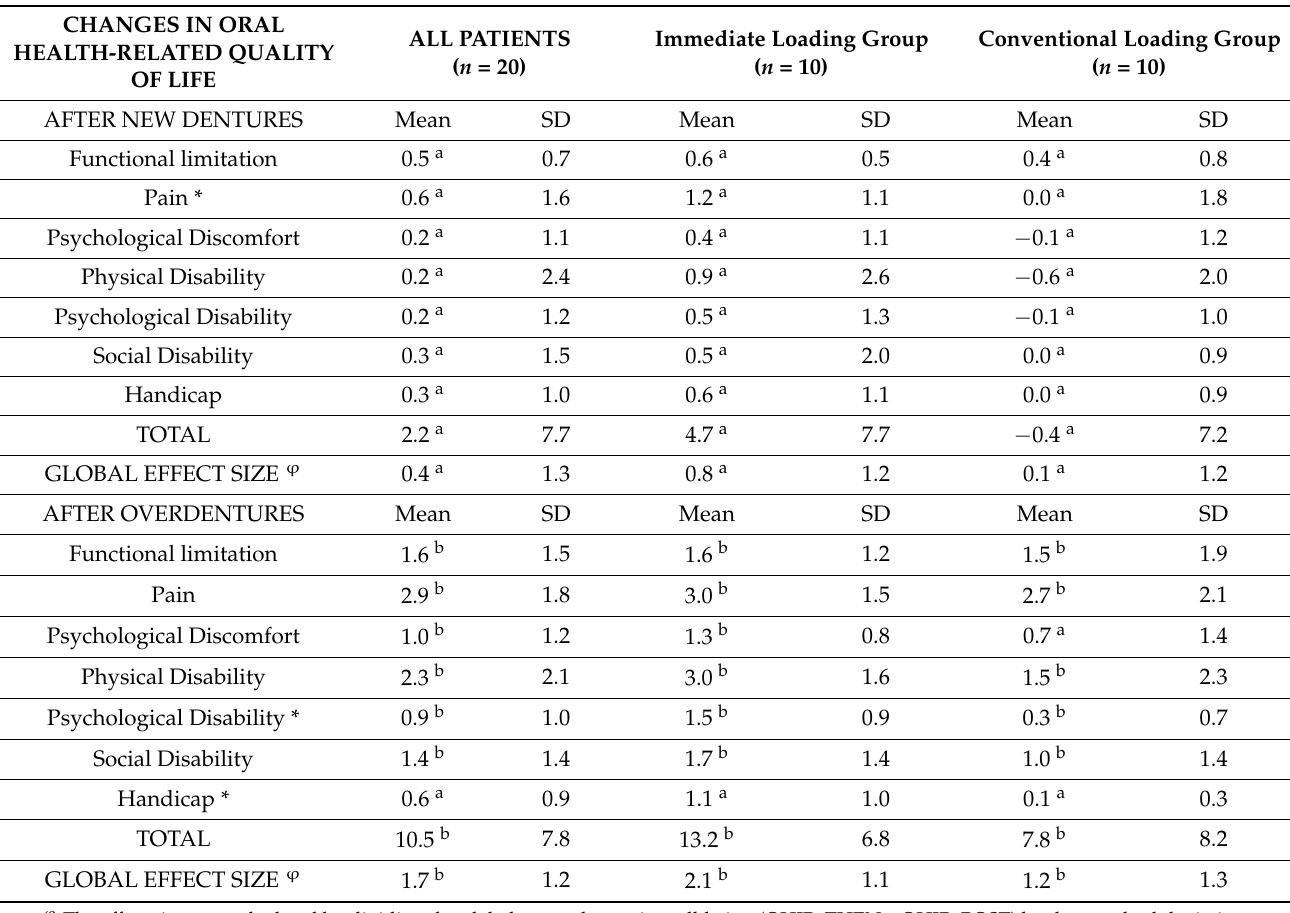
Table 9. Alpha changes (OHIP-THEN—OHIP-POST) in oral health-related quality of life and effect sizes ϕ after new dentures and overdentures ( n =